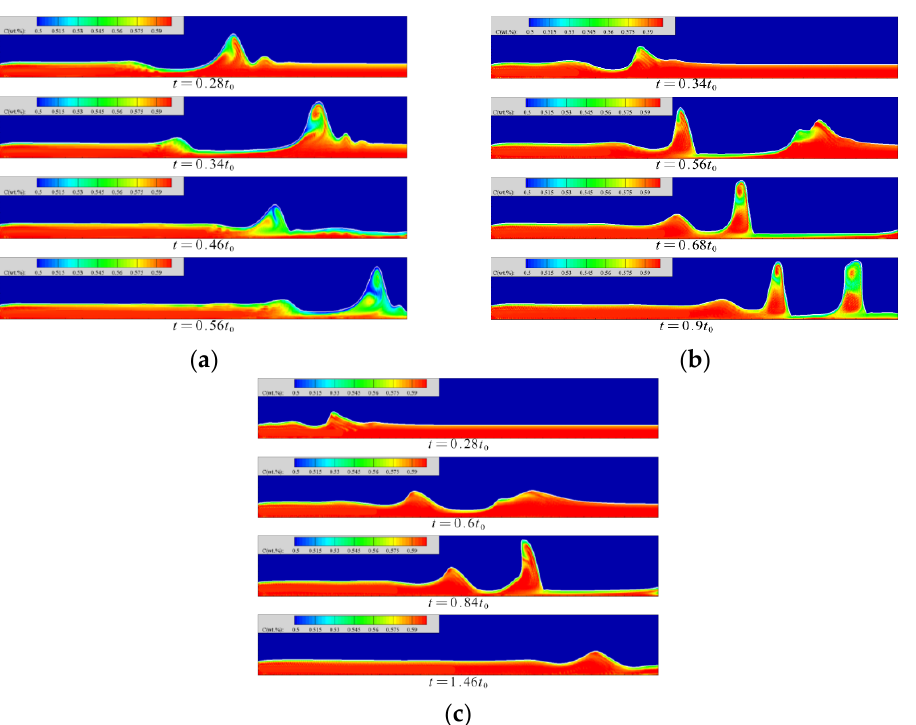
Figure 7. The concentration distribution in the liquid film at each moment. ( a ) Re = 5, ( b ) Re = 20, ( c ) Re = 40.